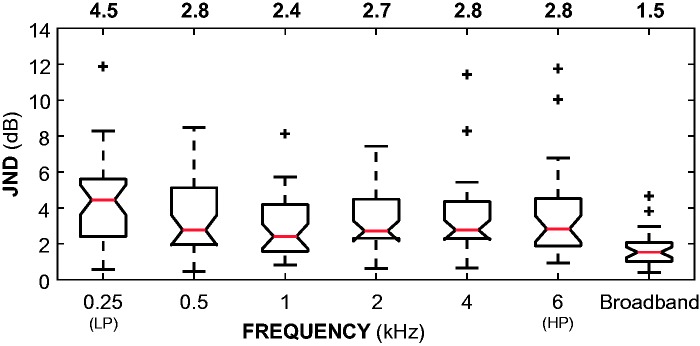
Box plots of JNDs (d’ = 1) across all 38 participants. Notches on each interquartile-range display the 95% confidence interval around the median (red line). Median JNDs for each condition are displayed above the plots. Confidence limits that are greater than quartiles suggest uncertain medians. Whiskers extend to the most extreme JNDs that are within 1.5 × the interquartile range. Pluses indicate outliers outside 1.5 × the interquartile range.JND = just-noticeable difference.